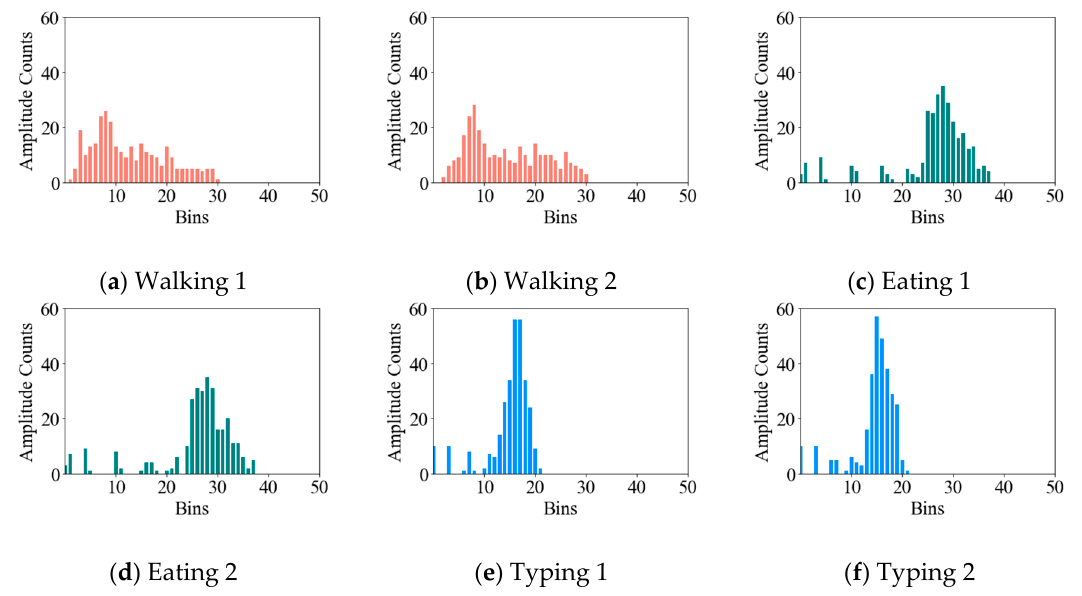
Figure 5. Amplitude counts in the amplitude bins for walking and in-place activities.